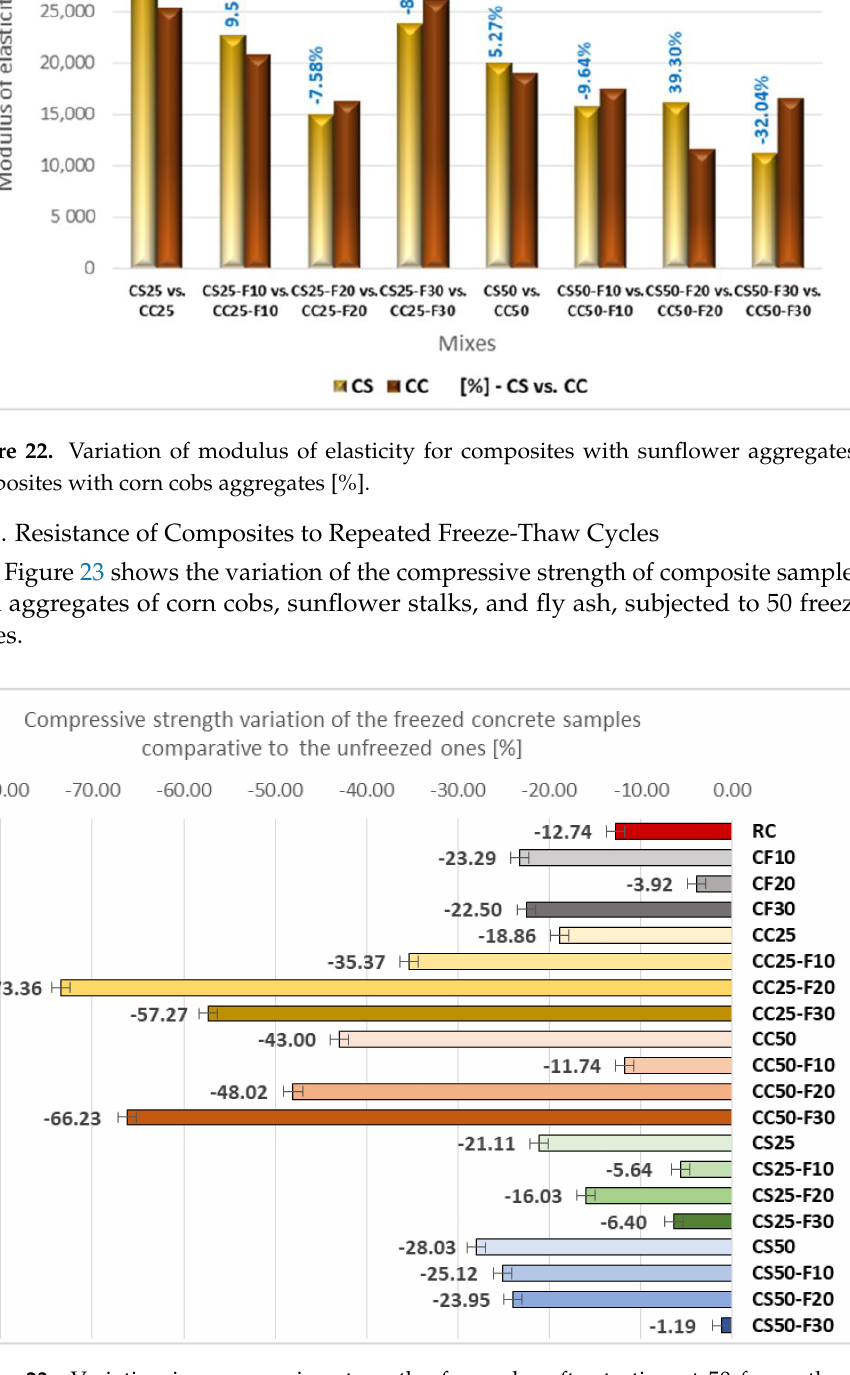
comparative to unfreezed samples